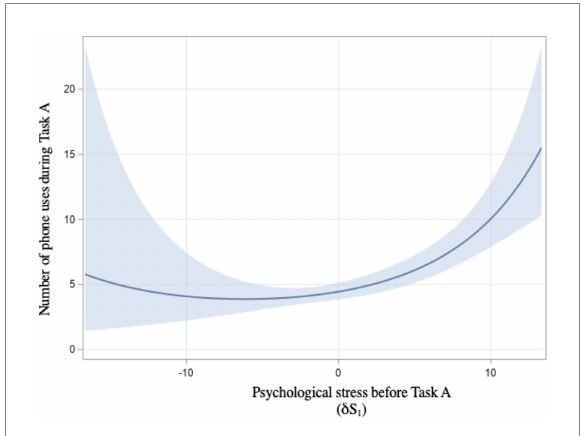
FIGURE 2 Relationship between psychological stress before Task A and number of phone uses with 95% confidence interval.